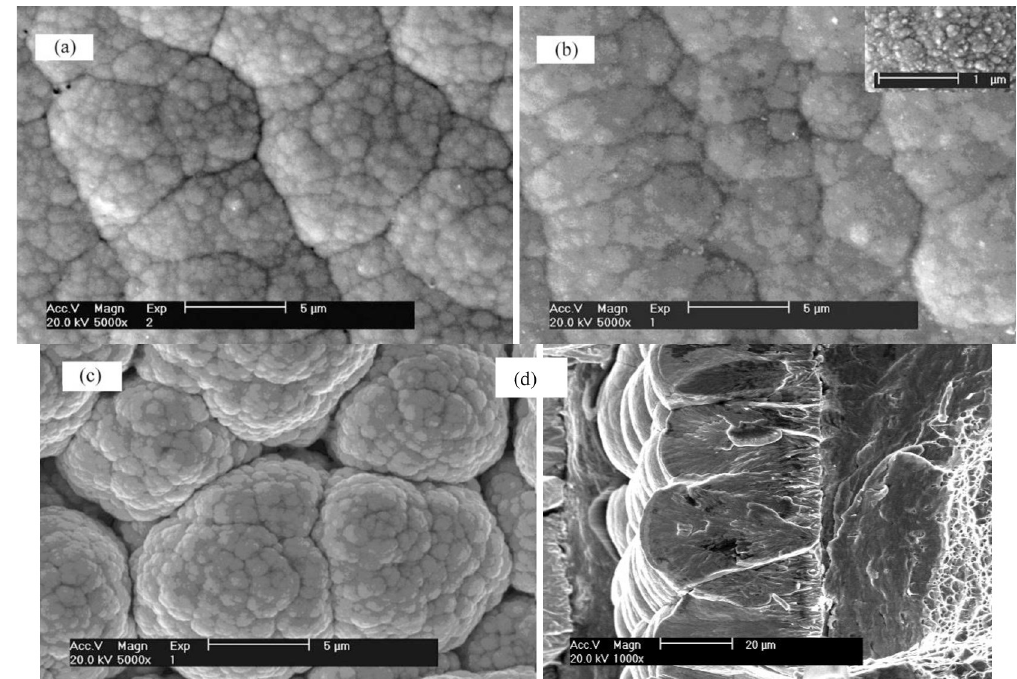
Fig 3. SEM images of the as-deposited and the deposits after heat treatment. (a) as deposited (b) 450˚C (c) 650˚C (d) cross- sectional of as-deposited.